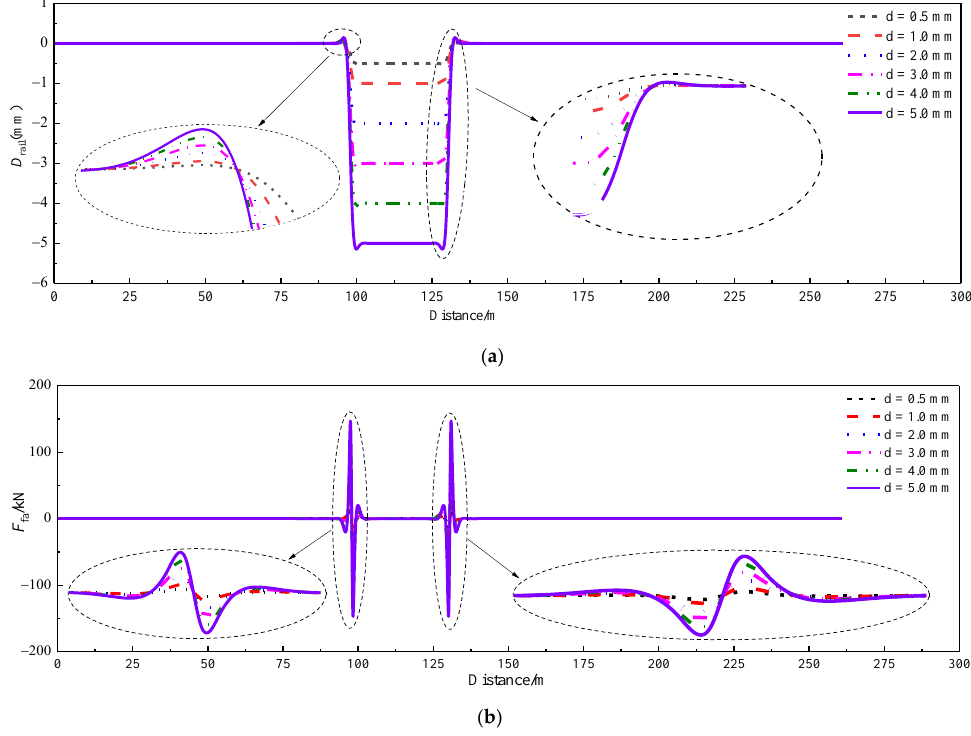
Figure 13. The influence of the girder vertical fault. ( a ) Rail deformation under different amplitudes of vertical girder fault; ( b ) fastener force under different amplitudes of vertical girder fault. Table 3. Rail mapping deformation area length and rail unevenness of girder vertical fault.